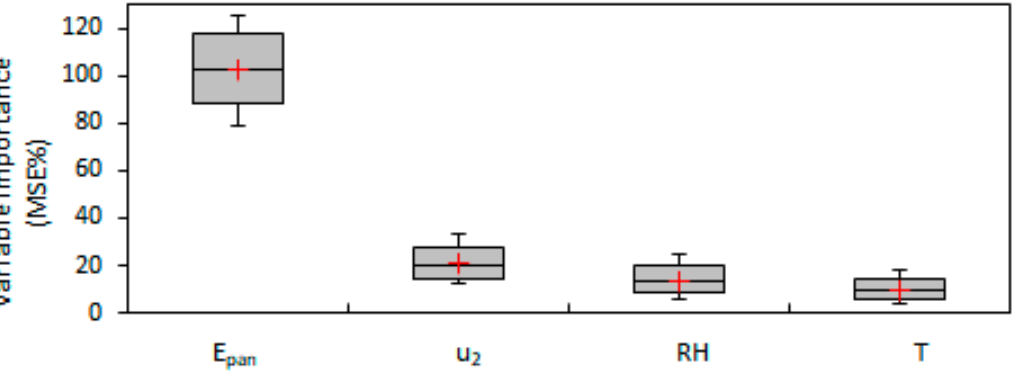
Figure 4. Range of the variables’ importance in the MRF analysis presented as modified box-whisker plots, with boxes adjusted to the 95% HPD interval (Epan: daily pan evaporation (mm d − 1 ), u 2 : daily wind speed at 2 m above ground surface (m s − 1 ), RH: daily relative humidity (%), T: daily temperature ( ◦ C)).